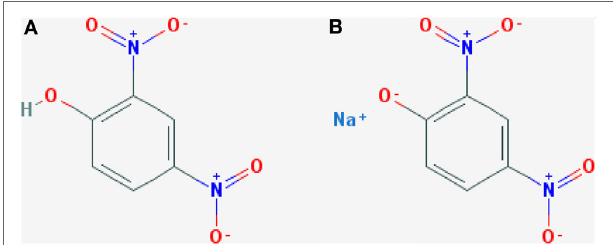
FigUre 1 | Chemical structure of 2,4-DNP produced in two forms: (a) 2,4-Dinitrophenol and (B) sodium dinitrophenolate. Taken from Petróczi et al. (19).